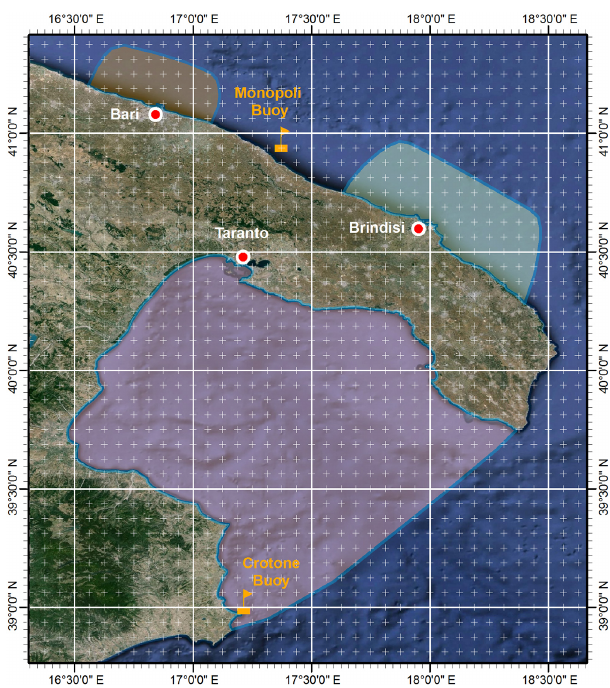
Figure 3. Computational domain outlines for the three areas in South Italy where the proposed multiparametric approach was ap- plied and locations of the Monopoli and Crotone buoys; the grid lines and points represent the WAVEWATCH III rectilinear grid (background image from Google Earth (2016); privately processed).